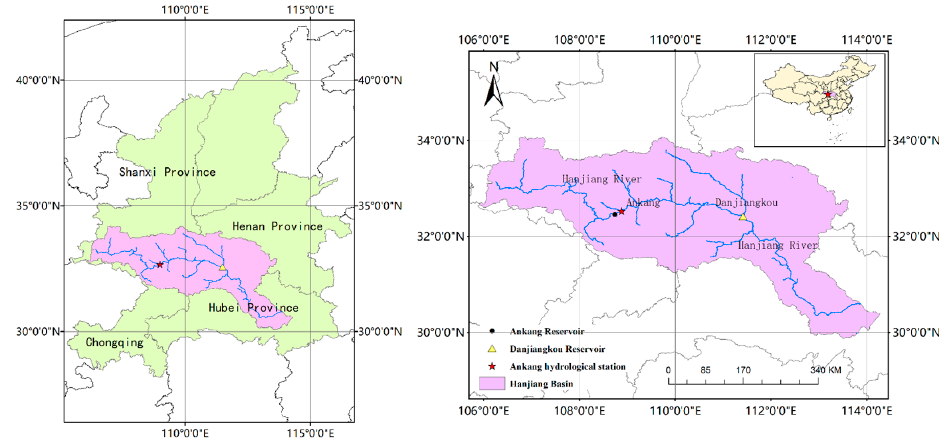
Figure 1. Overview of the Hanjiang River Basin.